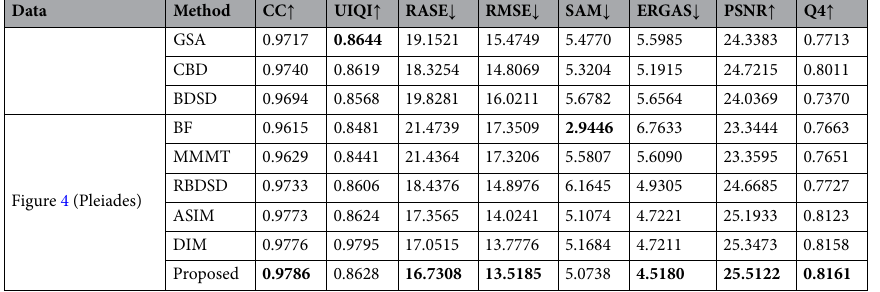
Table 5. Objective evaluation of the simulation experimental results shown in Fig. 4. Significant values are in